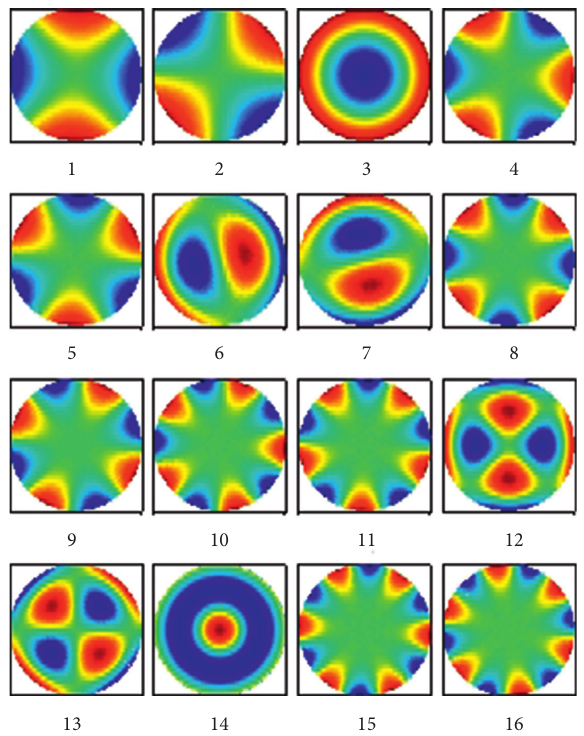
Figure 4: The reconstructed mode shapes of the disk with p �